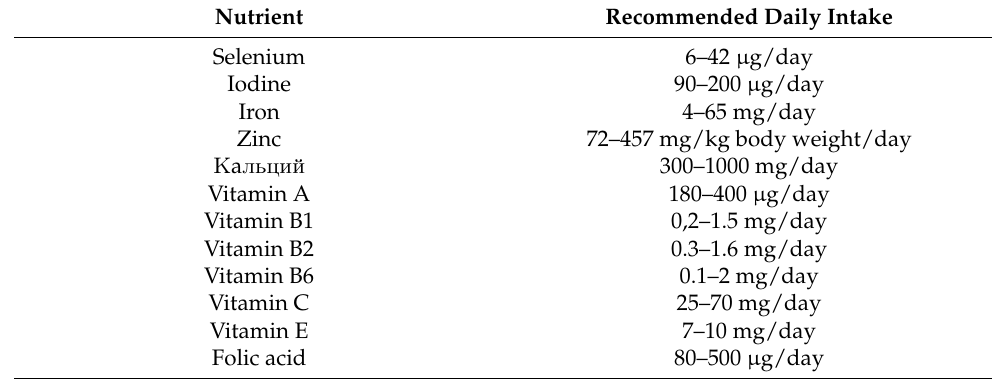
Table 1. The main nutrients for the normal functional state of the human body